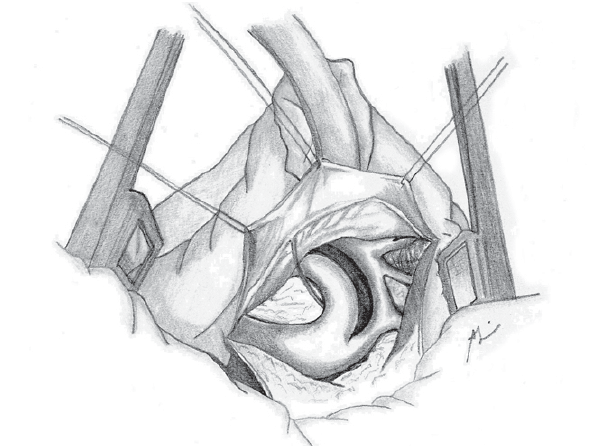
Fig. 2 - Anatomia cirúrgica da coarctação aórtica com hipoplasia do arco